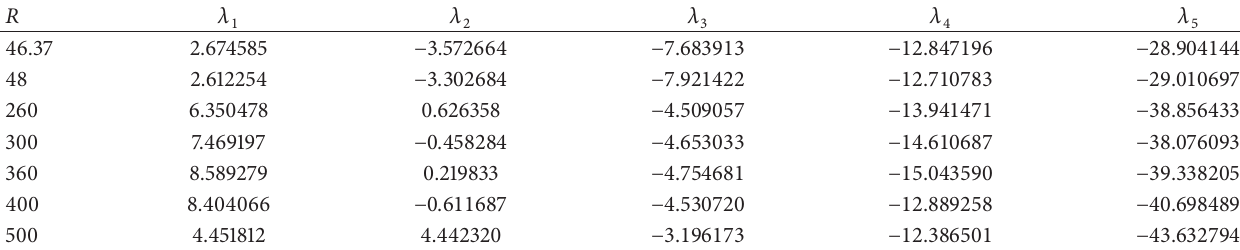
Table 1: Lyapunov exponents for system (12) computed from 10,000 data points for the case where Le = 0.1 and 𝑅 𝑠 = 15